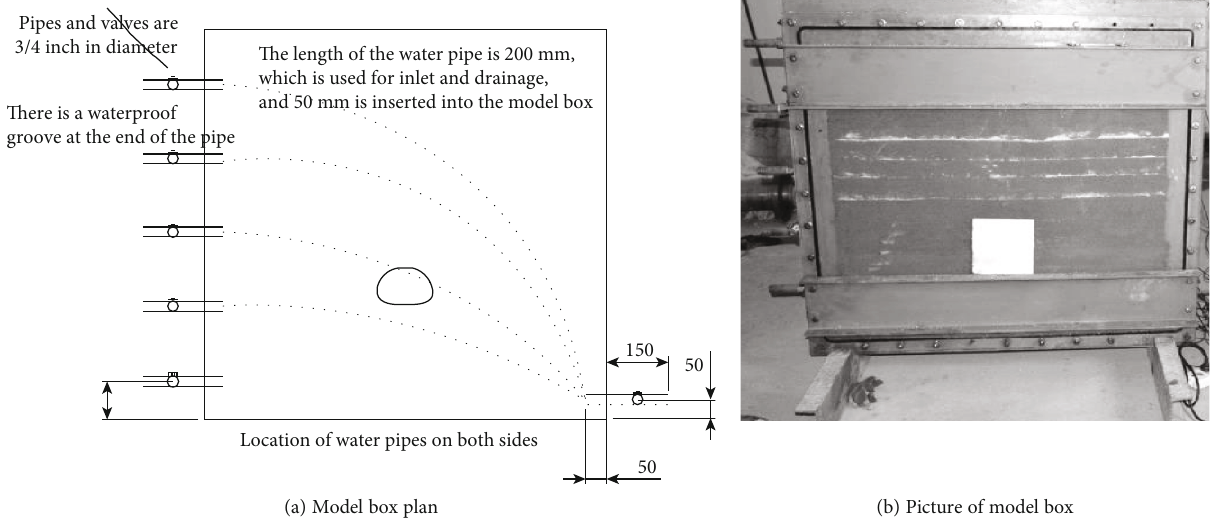
Figure 1: Test model box (unit